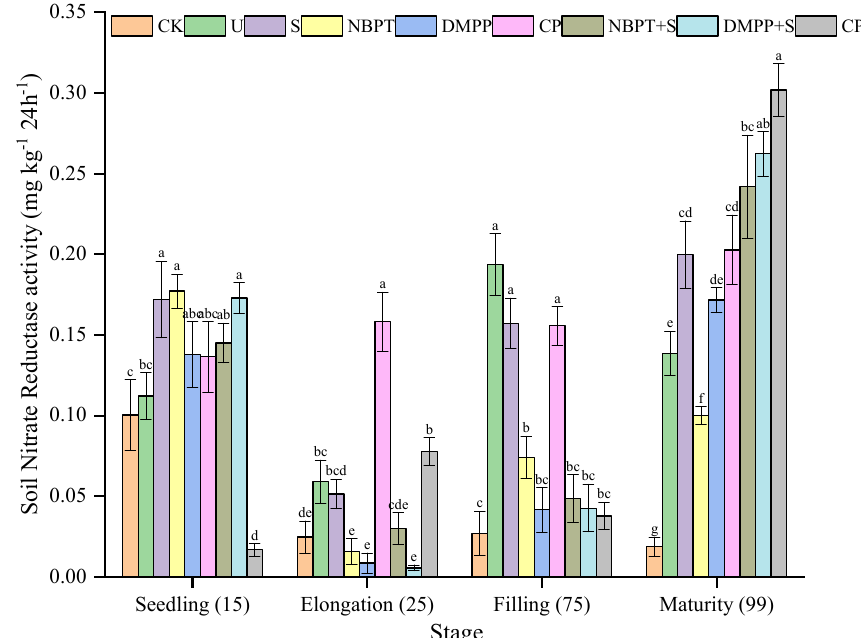
Figure 4. Soil Nitrate Reductase (NR) activity of different treatments. Different letters indicate significant differences between different treatments at p < 0.05 by Tukey test.